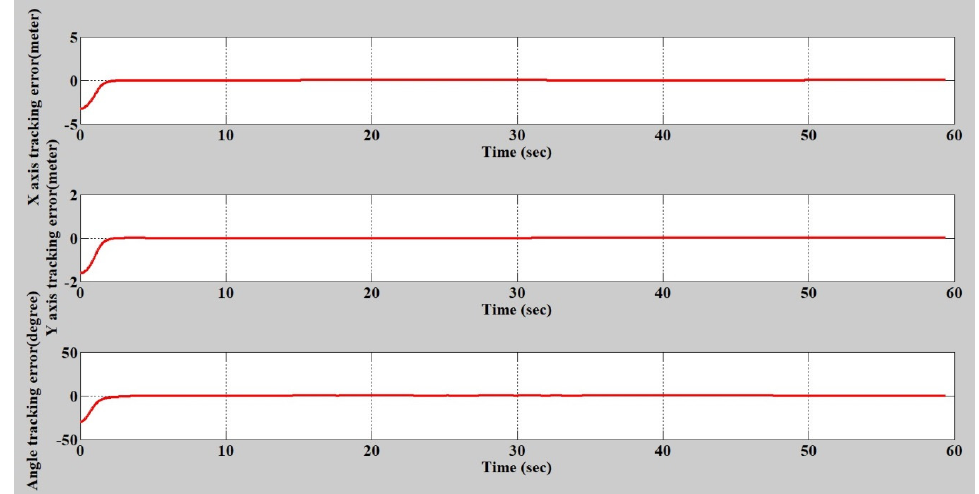
Figure 13. Results of S-type trajectory tracking errors concerning initial point ( x c = − 1.9 m, y c = 0 m).